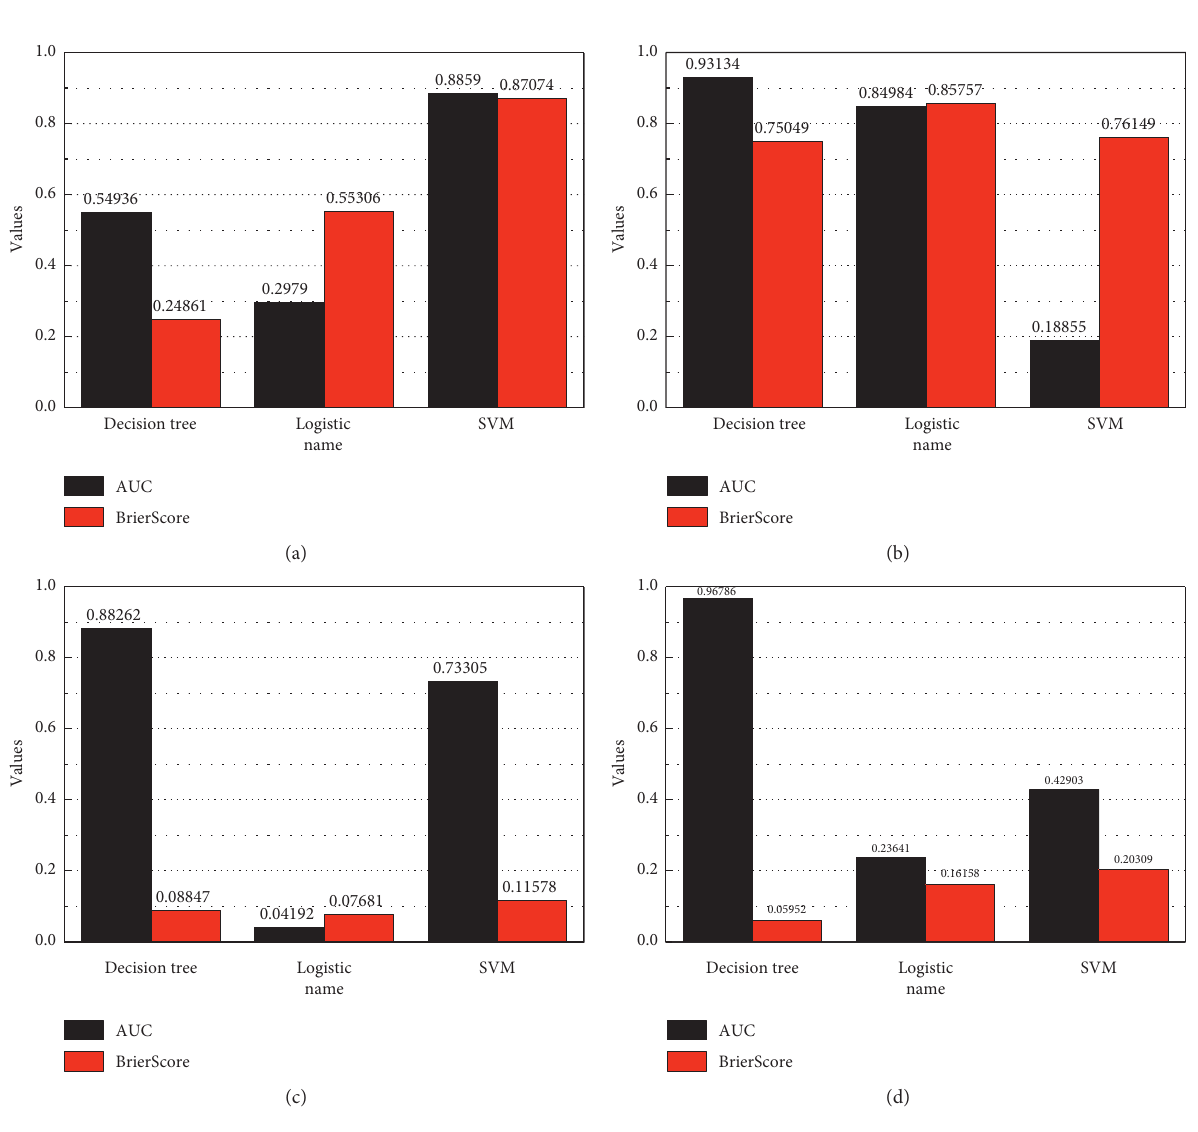
Figure 6: Sample experimental